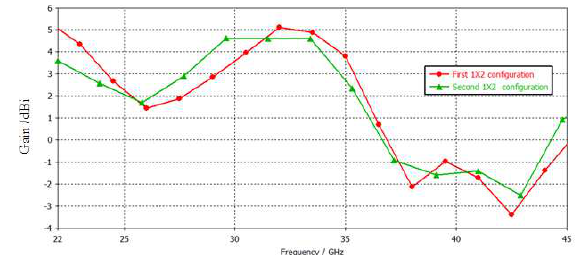
Fig.7. Simulated gain results of the proposed (a) and (b) 1X2 MIMO antenna.